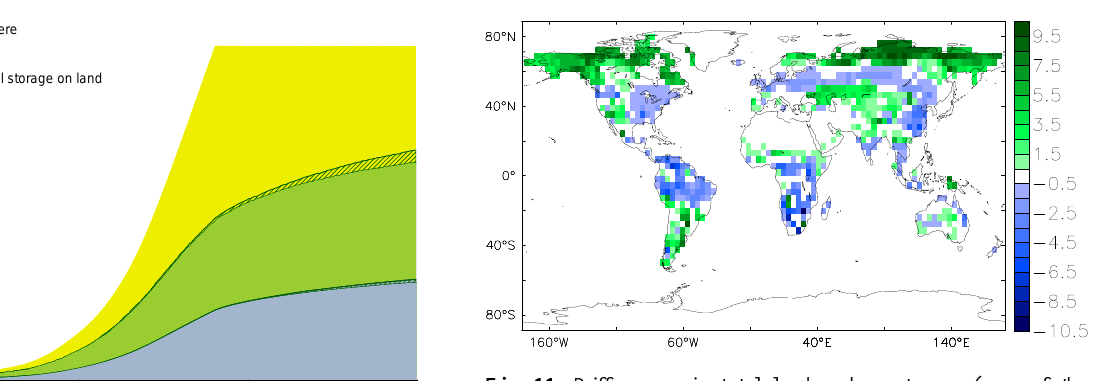
Fig. 11. Differences in total land carbon storage (sum of the biomass, soil, and litter pool) due to changes in vegetation cover in [kgCm 2 ] (DYN – STAT) averaged over the period from the year 2270 until